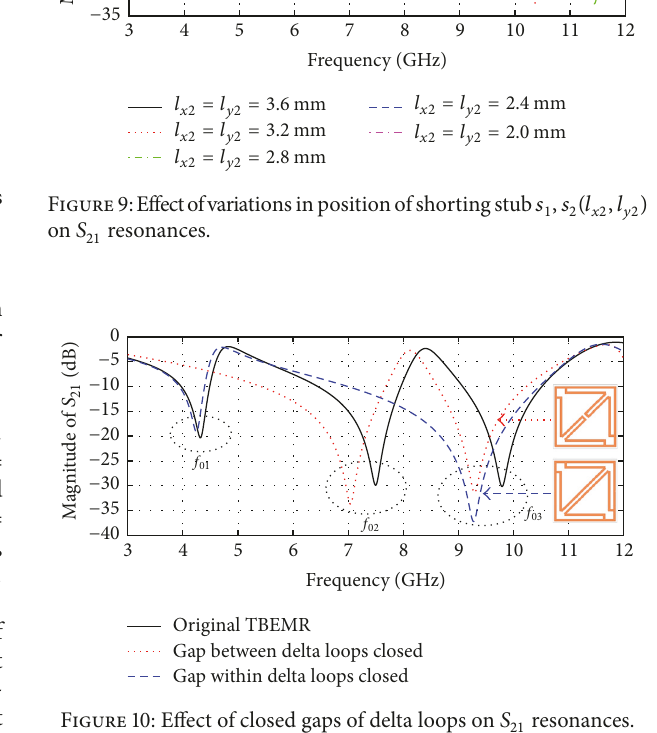
Figure 10: Effect of closed gaps of delta loops on 𝑆 21